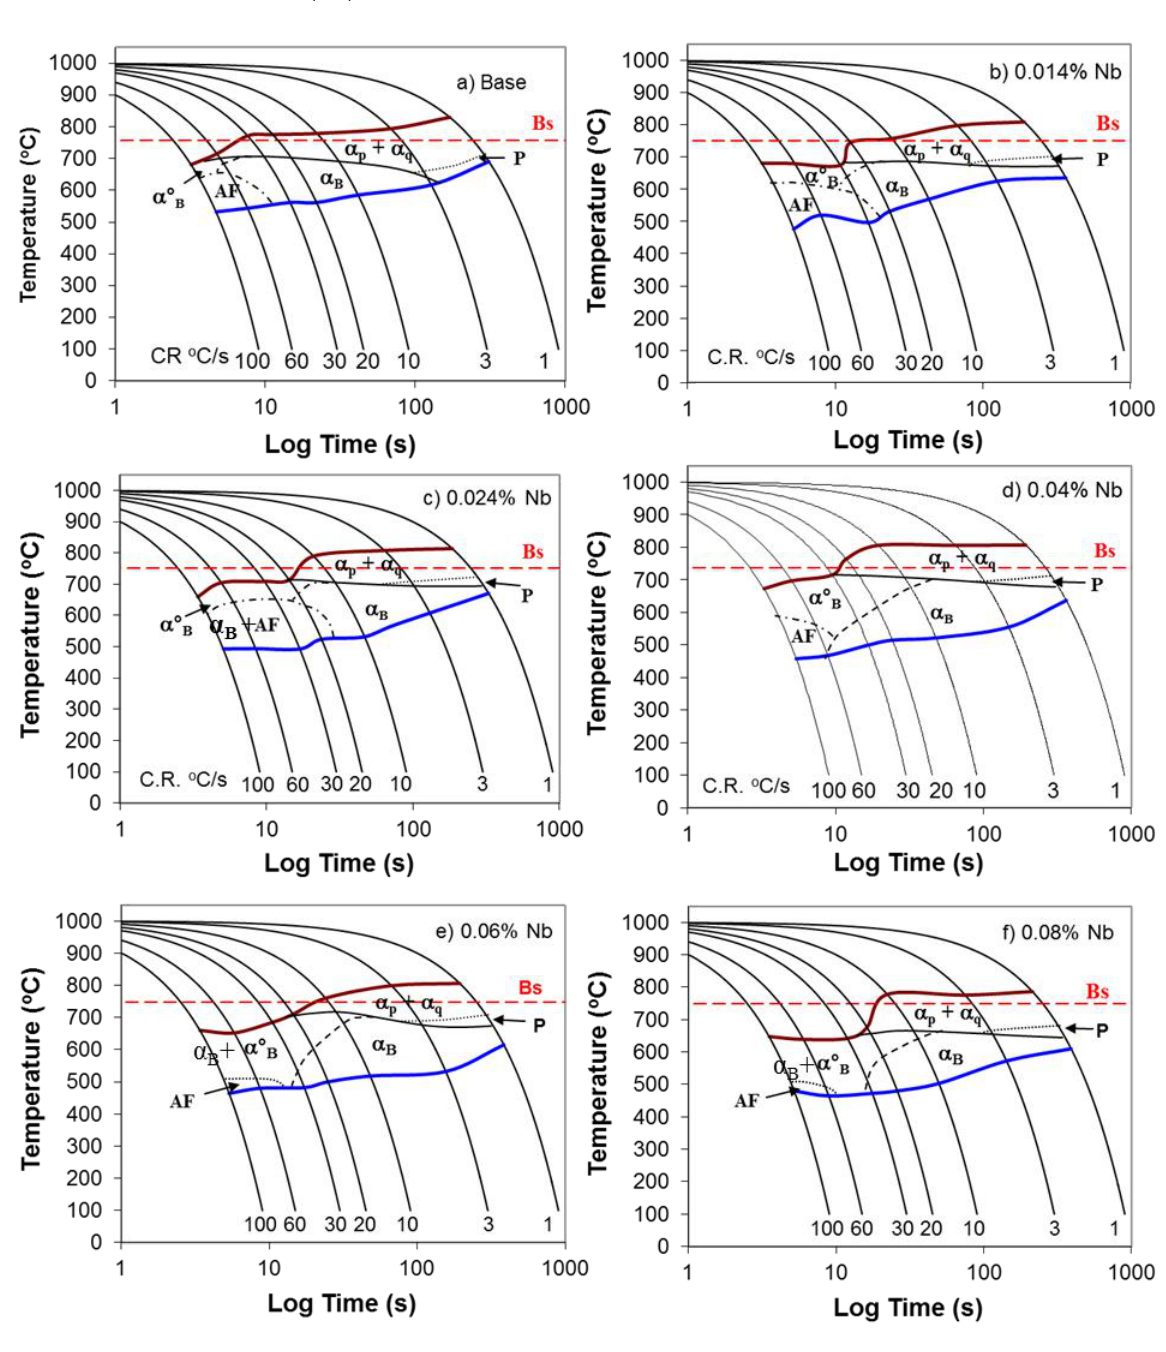
Figure 11. CCT diagrams for ( a ) base UCS steel and for different Nb levels, ( b )